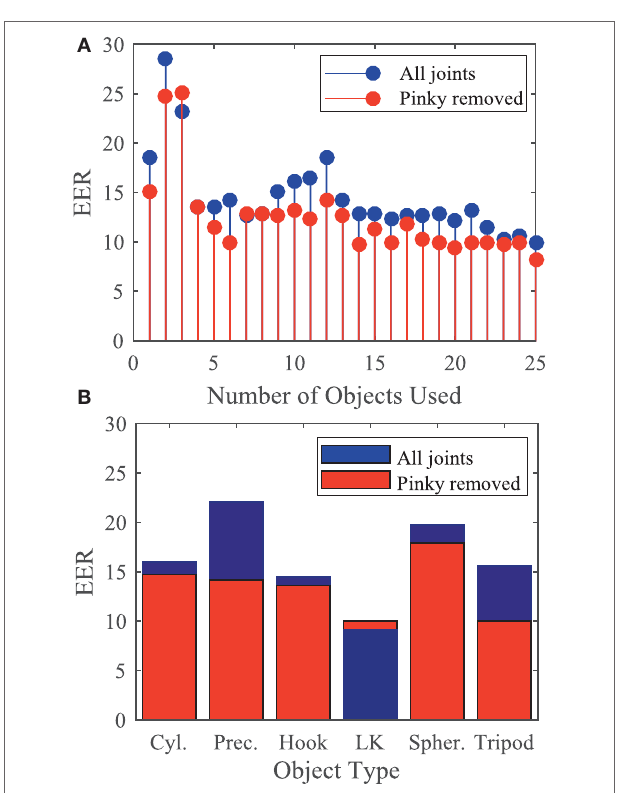
FigUre 7 | (a) Equal error rate (EER) when increasing number of objects are used. Using the first six highest ranked objects produces an EER of 10% when pinky is removed. (B) Using only five lateral key grasps produces an EER of 9.17% when the pinky is